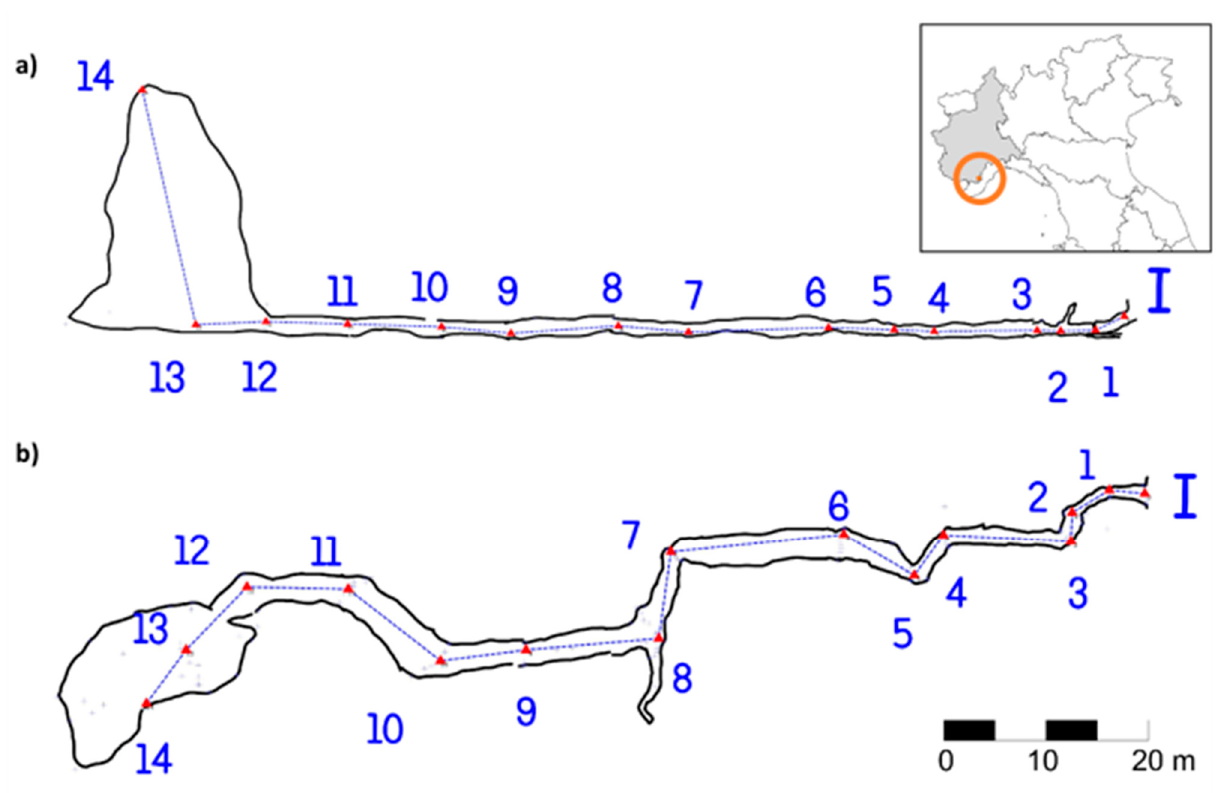
Figure 2. ( a ) Gazzano cave cross-section from the traditional survey; ( b ) map of the cave with the polygonal survey; inset) Gazzano location map.